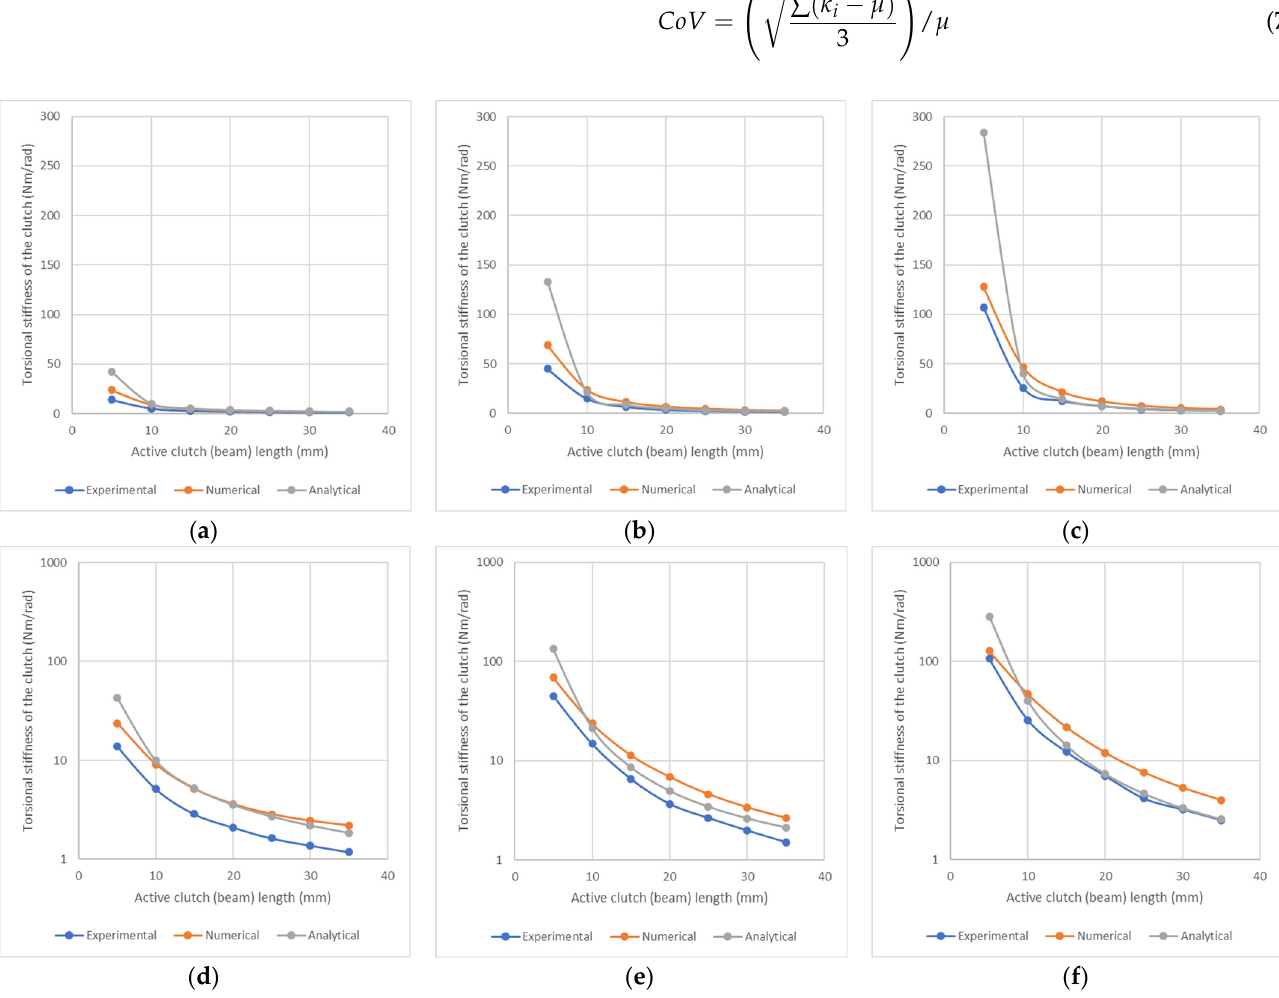
Figure 5. Experimental, numerical, and analytical stiffness of the joint versus active clutch length for the various radial location of the elastic beams. ( a ) R = 5 mm, ( b ) R = 10 mm, ( c ) R = 15 mm, ( d ) R = 5 mm (logarithmic scale), ( e ) R = 10 mm (logarithmic scale), and ( f ) R = 15 mm (logarithmic scale).